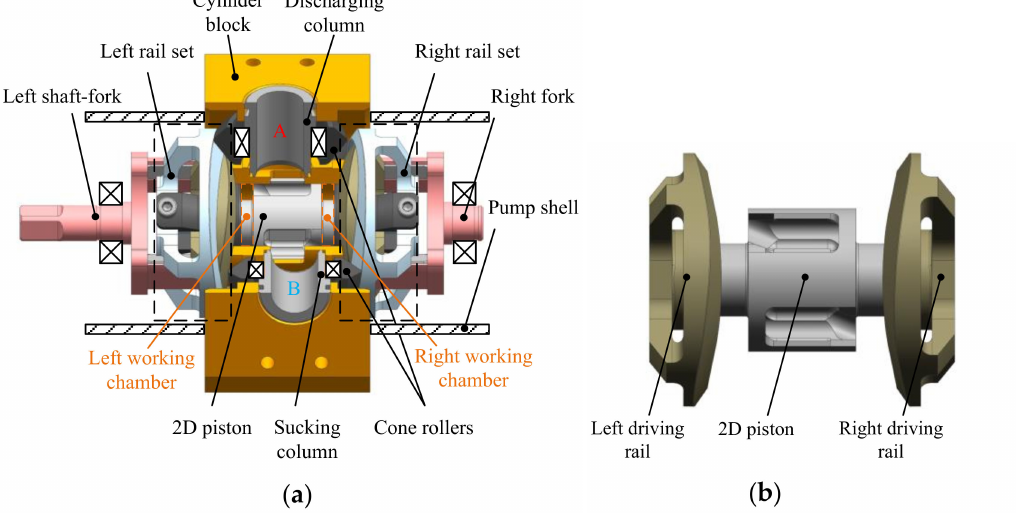
Figure 3. Mechanical structure of a 2D piston pump with the new 2D motion-converting mechanism: ( a ) Overview; ( b ) Driving set; ( c ) Balancing